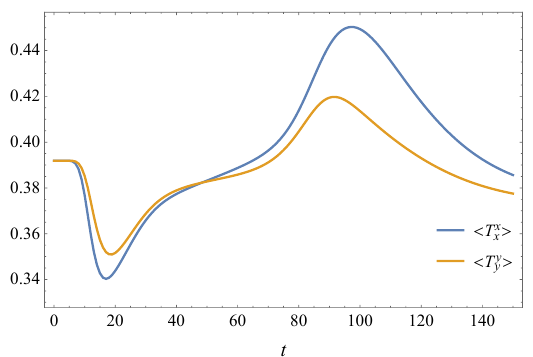
Figure 9. The longitudinal (blue) and transverse (orange) pressures of the shock wave collision at the merger point as a function of